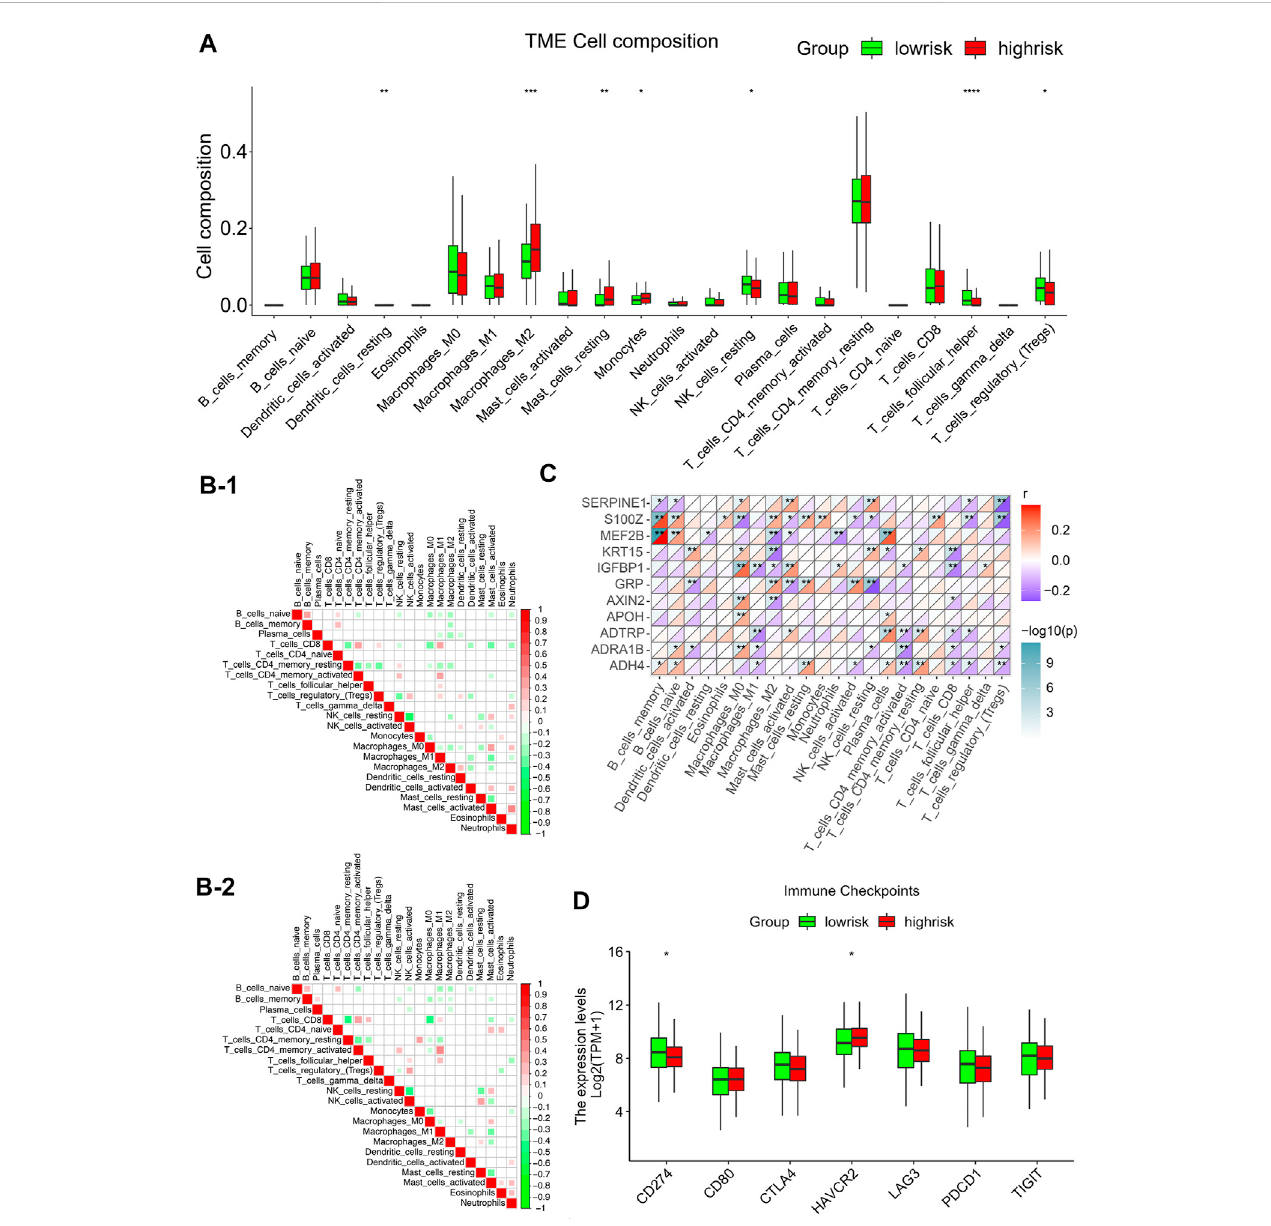
FIGURE 6 Correlations between in fi ltration of tumor-associated immune cells and risk modeling (A) Differential analysis of the level of in fi ltration of 22 immune cellsinthehighandlowriskgroups. (B) Differentcorrelationpatternsamong22immunecellsubsetsinthehighandlowriskgroups(B-1:highriskgroup,B-2: low risk group). (C) Heat map of the correlation between 11 gene signature and 22 immune cells. Red is used to represent the positive correlation between genesandimmunecells,andblueisusedtorepresentthe p -valueofthecorrelationbetweenthetwo.(* p < 0.05;** p < 0.01;*** p < 0.001). (D) Expression of common immune checkpoints in high and low risk